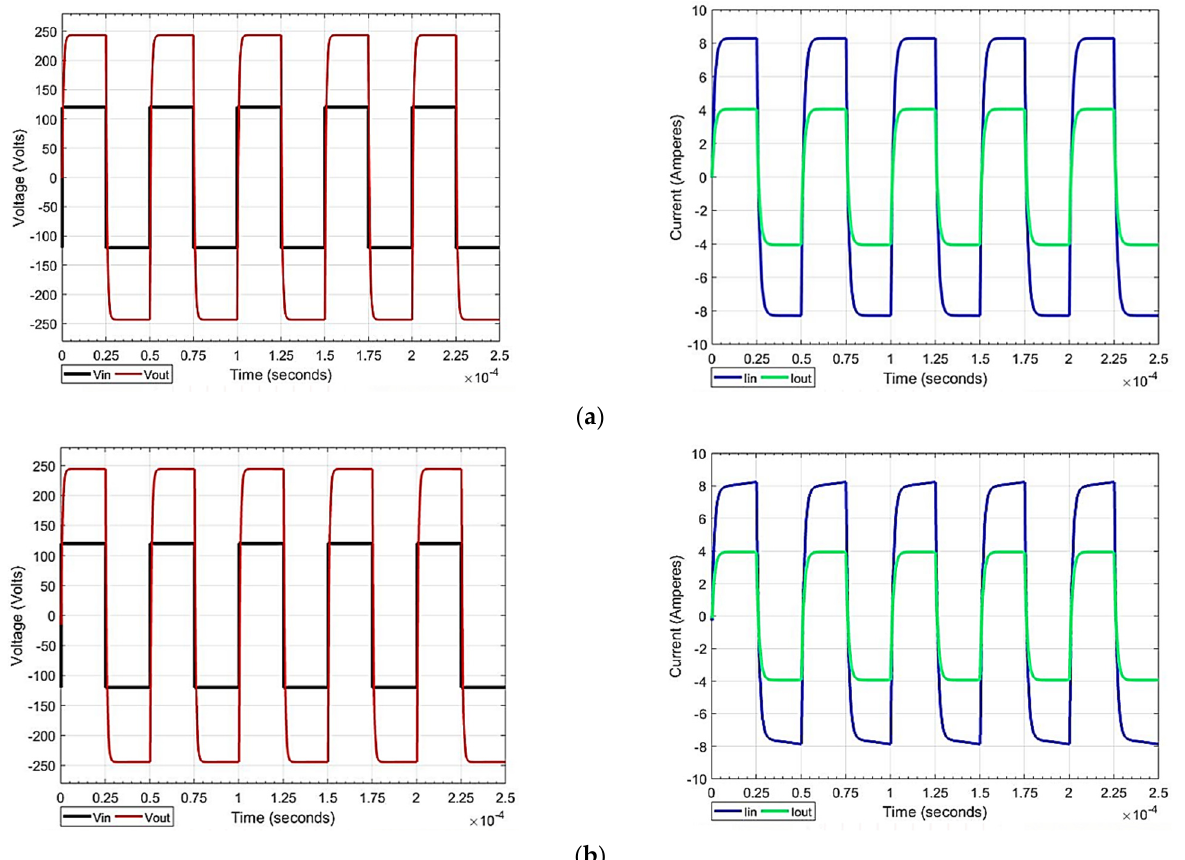
Figure 7. Input and output voltages and current for MFTs: ( a ) Nanocrystalline core, ( b ) ferrite core. Table 7. Parameters of the simulation model.